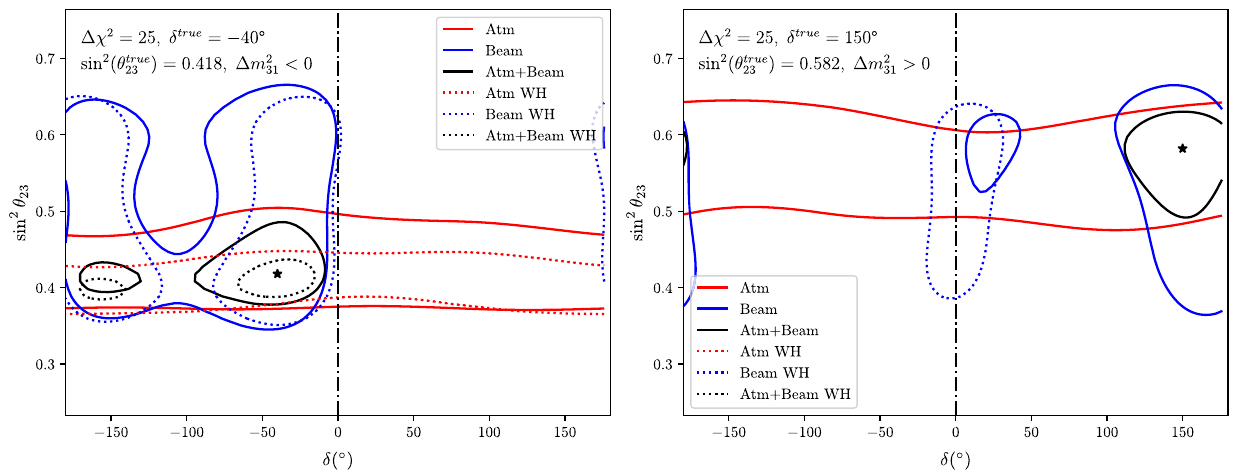
Fig. 5 Allowed regions at (cid:7)χ 2 = 25 for different assumed values of sin 2 θ 23 and δ represented by the star for a 540 km baseline (Garpen- berg location). The red curves correspond to the atmospheric dataset alone, the blue to the beam-only information and the black curves to